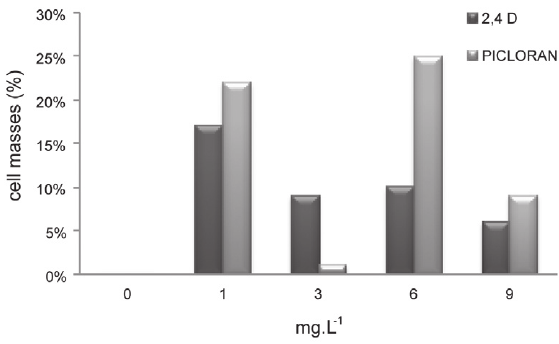
Figure 1 - Callus percentage on oil palm tenera hybrid ( Elaeis guineensis ) leaves induced with 2,4D and